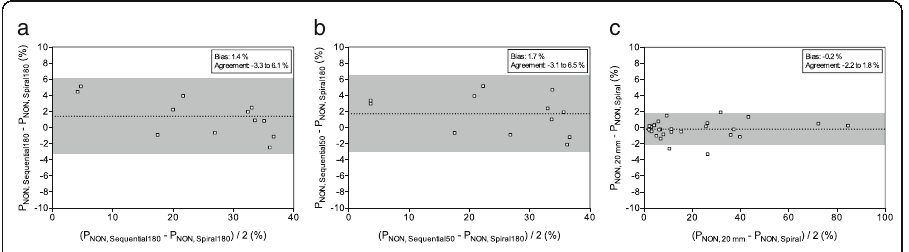
Fig. 3 Bland – Altman plot for the non-aerated lung compartment. Comparisons are performed in pigs between the reference spiral scan and the sequential scan at 180 mAs ( a ) and 50 mAs ( b ), and in humans between the entire spiral scan and the extrapolation from slices interleaved by 20 mm in humans ( c